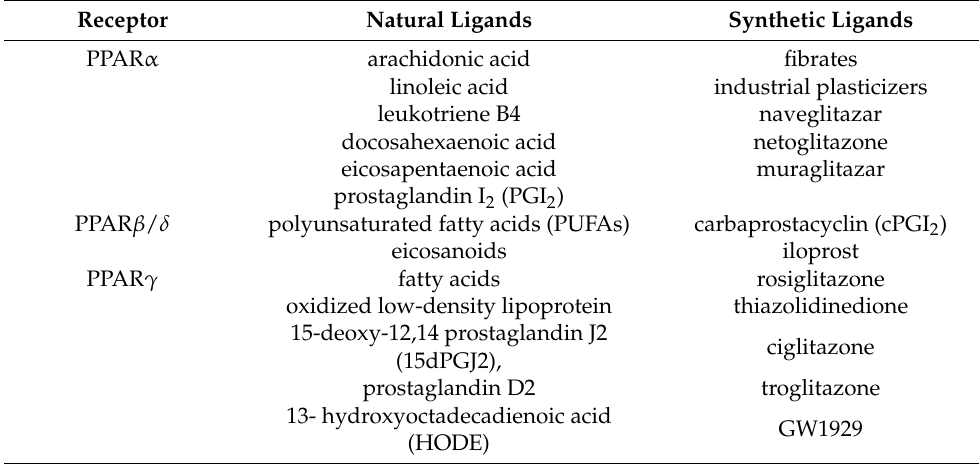
Table 1. Natural and synthetic ligands of peroxisome proliferator-activated receptors (PPARs).